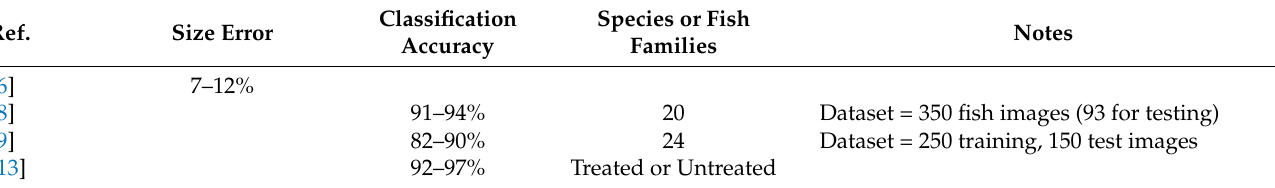
Table 9. Comparison with the referenced